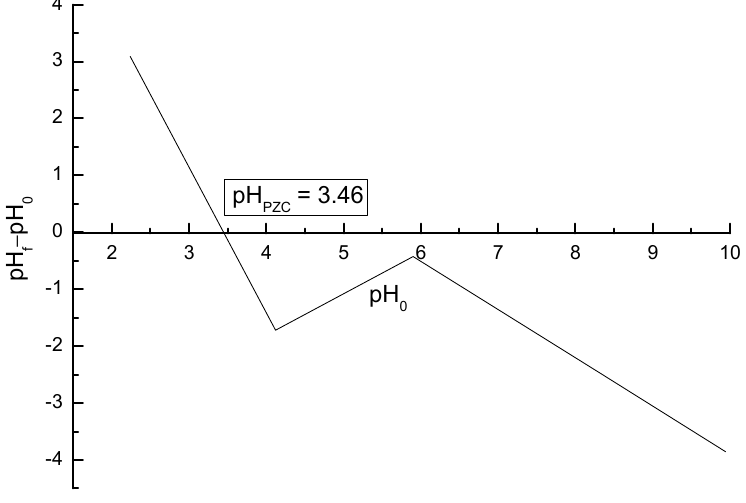
Figure 5. ACOP pH